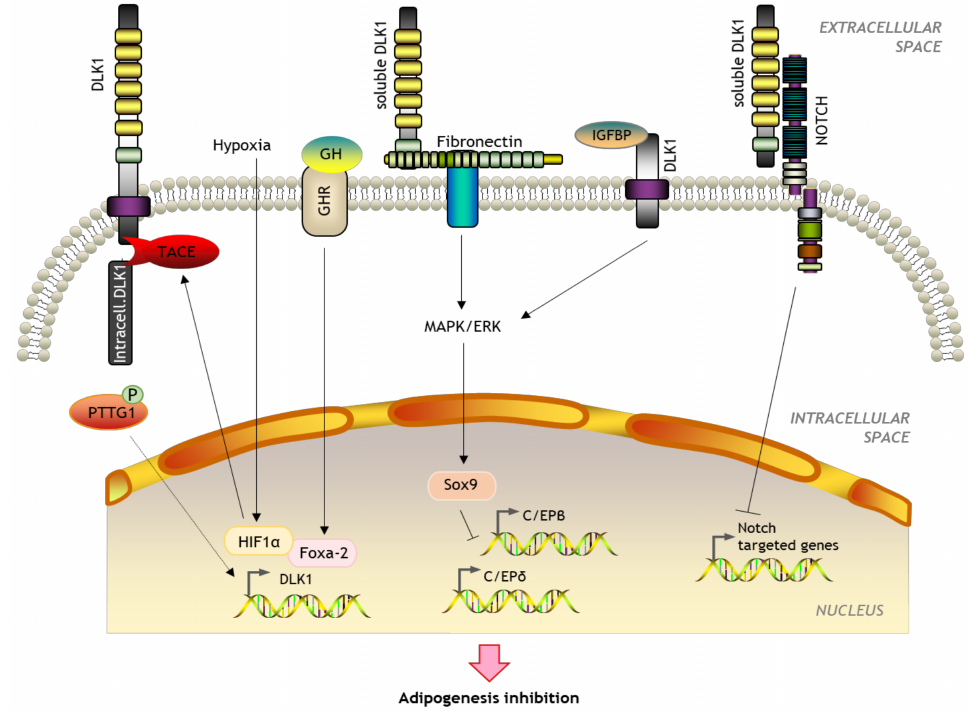
Figure 5. Schematic representation of the role of DLK1 in